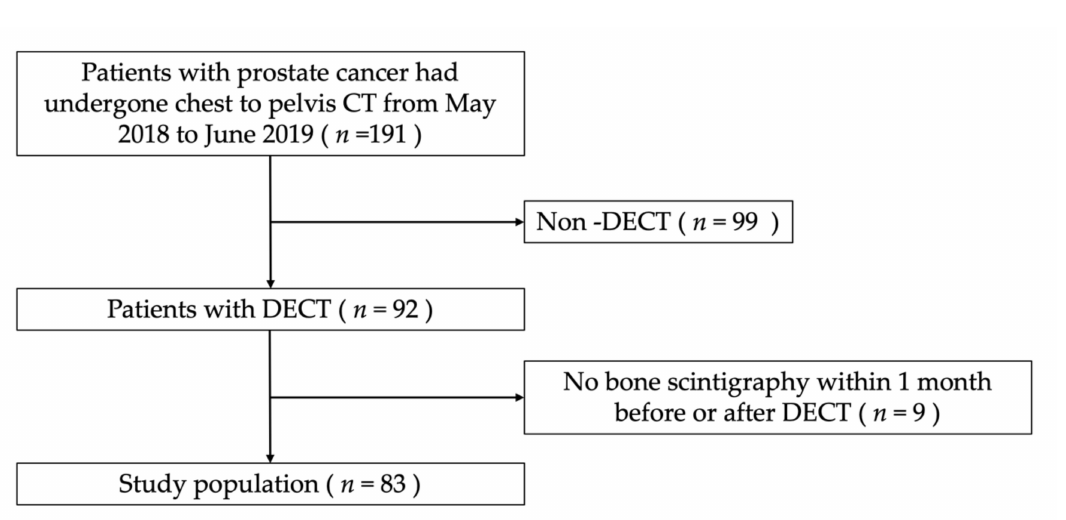
Figure 1. Study flow chart. DECT, Dual-energy computed tomography; PC, Prostate cancer; BC, Breast cancer; HAP Hydroxyapatite.